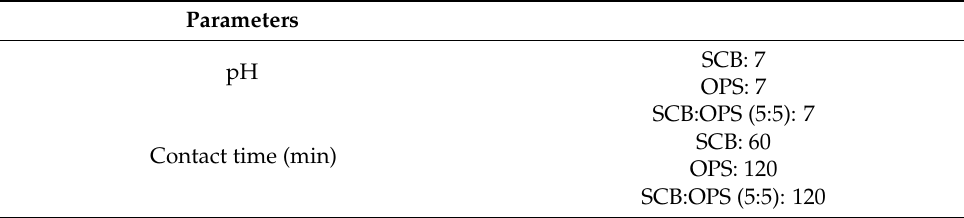
Table 1. Optimum pH and contact time used for removal of Pb(II) in real water samples.